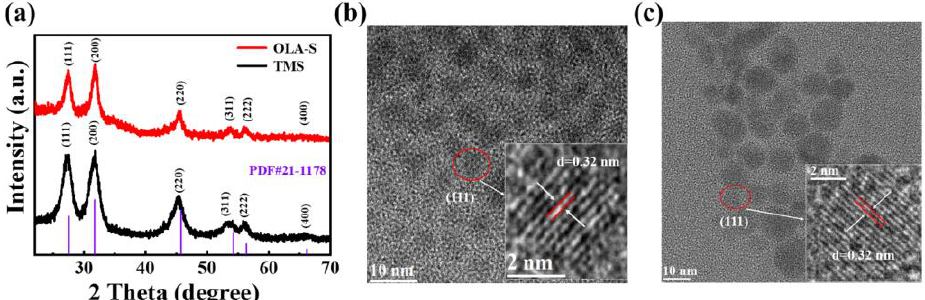
Figure 2. ( a ) XRD patterns of colloidal AgBiS 2 NCs based on TMS and OLA–S; ( b , c ) HR–TEM images of TMS–based and OLA–S–based colloidal AgBiS 2 NCs, respectively. To further reveal the effect of the sulfur source on the quality of the obtained colloidal AgBiS 2 NCs, the photoluminescent (PL) spectra of the TMS–based and OLA–S–based